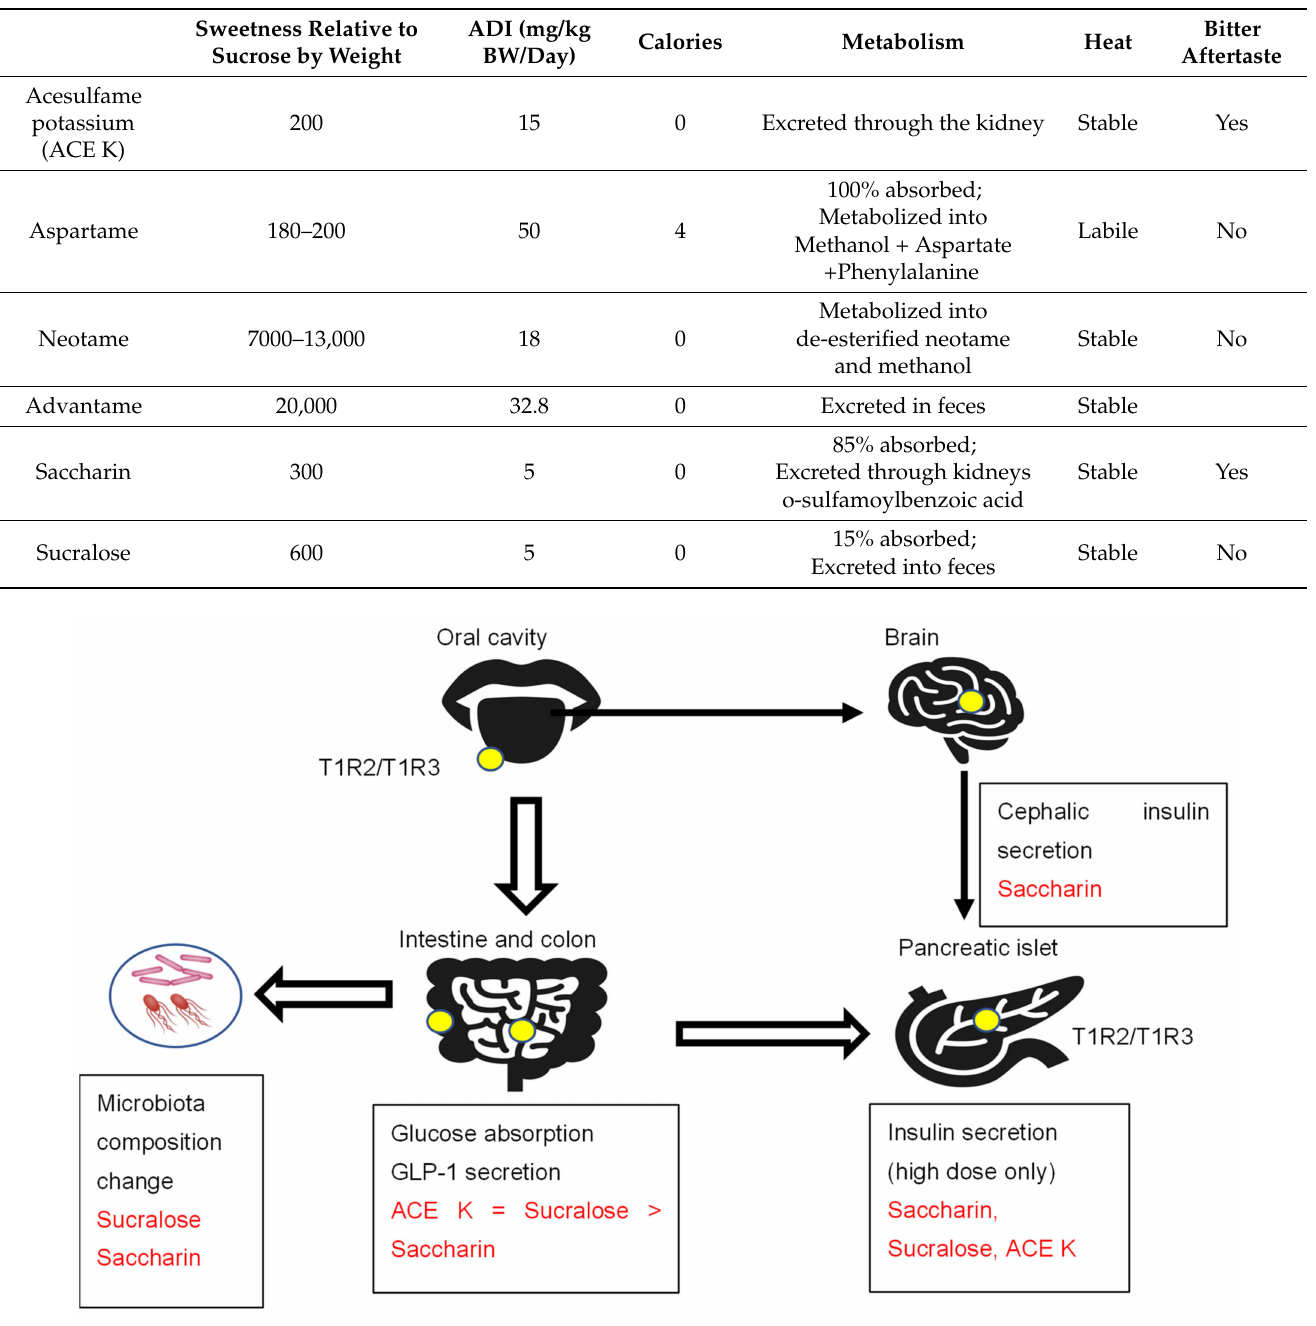
Table 1. Characteristics of artificial sweeteners.